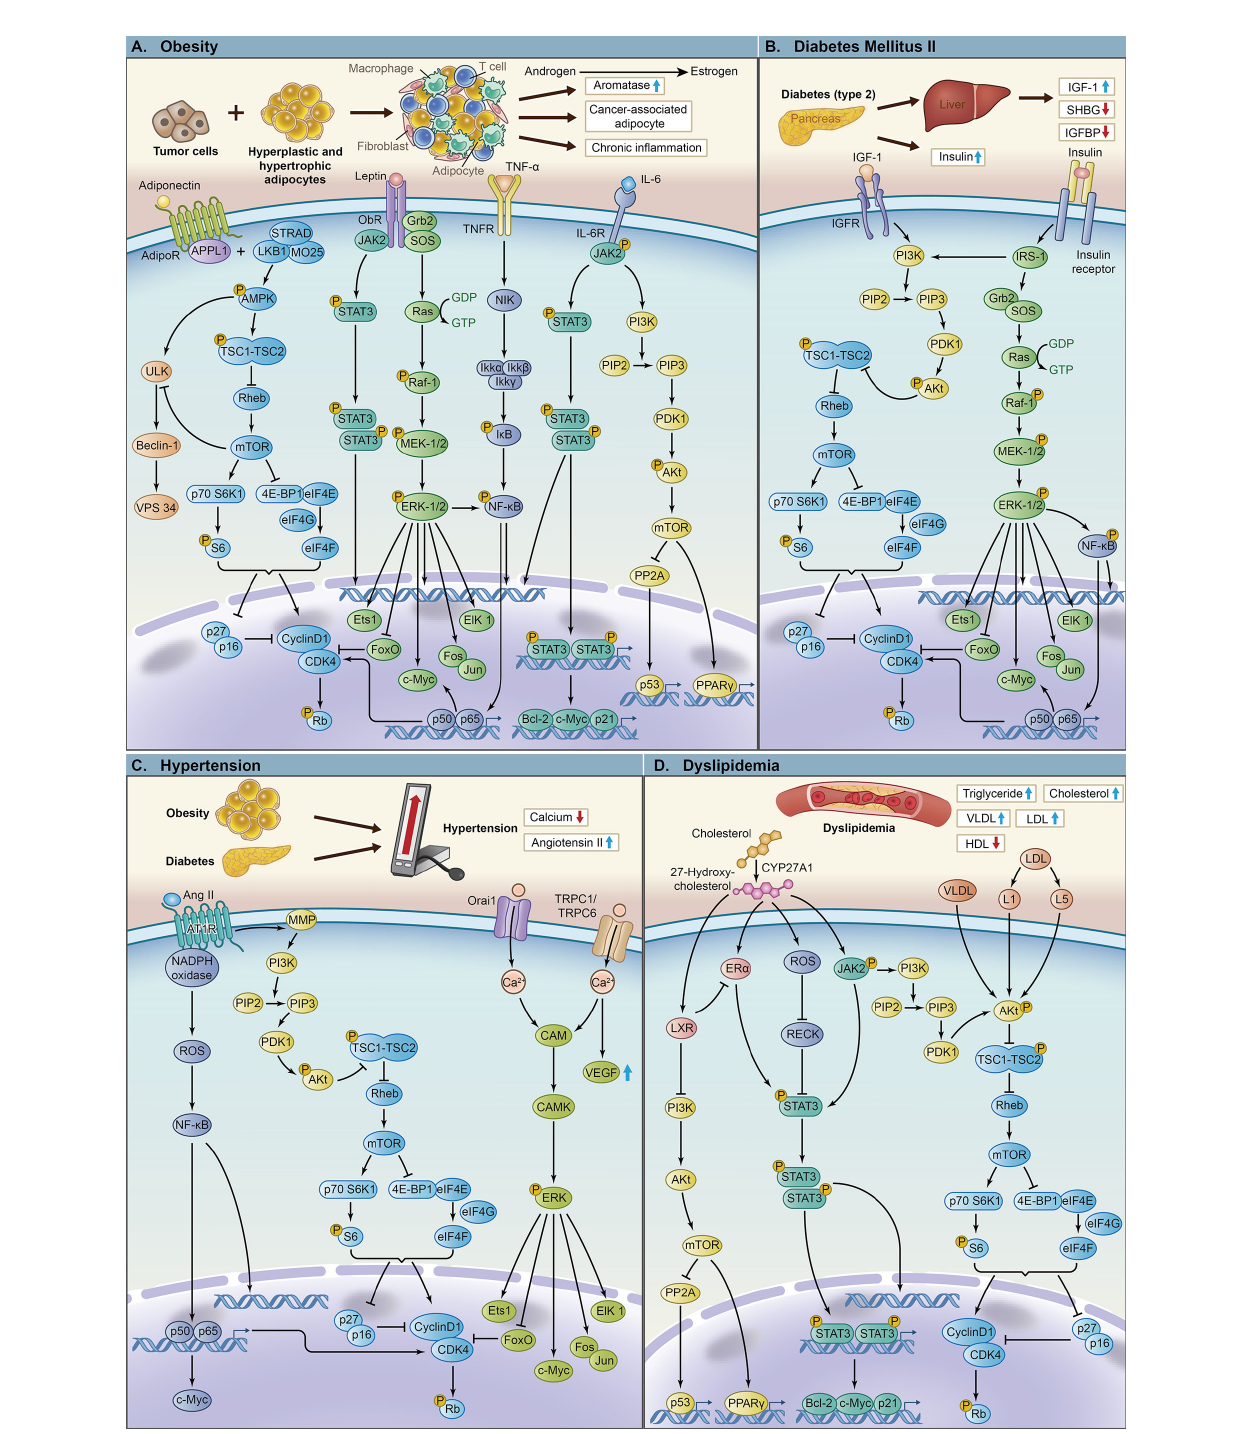
FIGURE 2 | The key pathways and molecular mechanisms of components of metabolic syndrome leading to tumor proliferation, invasion and metastasis. (A) The mechanism of obesity and its related key molecules leading to breast cancer with important signaling pathways, including LKB1/AMPK/mTOR, AMPK/ULK, JAK2/ STAT3, Ras/Raf/MEK/ERK, NF- k B and PI3K/Akt/mTOR. (B) The mechanism of diabetes mellitus type 2 and its related key molecules leading to breast cancer with important signaling pathways, including PI3K/Akt/mTOR, Ras/Raf/MEK/ERK and NF- k B. (C) The mechanism of hypertension and its related key molecules leading to breast cancer with important signaling pathways, including NF- k B, PI3K/Akt/mTOR and CAM/CAMK/ERK. (D) The mechanism of dyslipidemia and its related key molecules leading to breast cancer with important signaling pathways, including PI3K/Akt/mTOR, JAK2/STAT3 and ER a